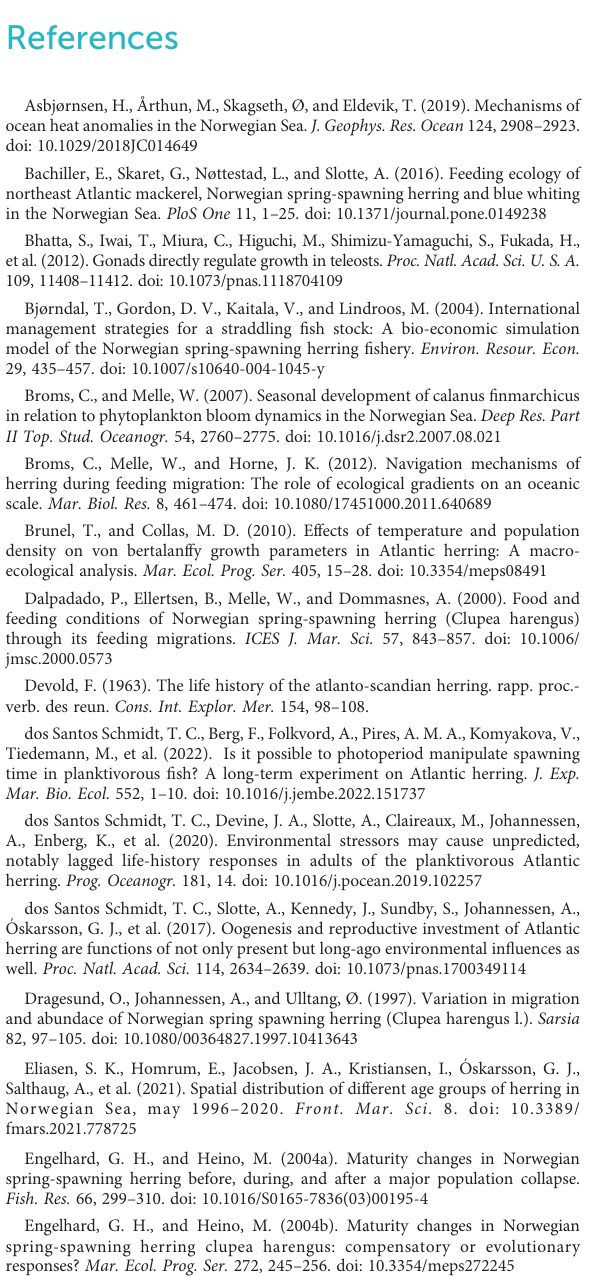
SUPPLEMENTARY FIGURE 8 Modelled spatiotemporal changes in centre of gravity (CG) of length at age for all ages 3-10+ (vertically) and season (horizontally). The variations in CG are shown split between two groups of herring having body length, fi sh weight and gonad weight either above (red) or below (blue) average. SUPPLEMENTARY FIGURE 9 Modelled spatiotemporal changes in centre of gravity (CG) of somatic condition for all ages 3-10+ (vertically) and season (horizontally). The